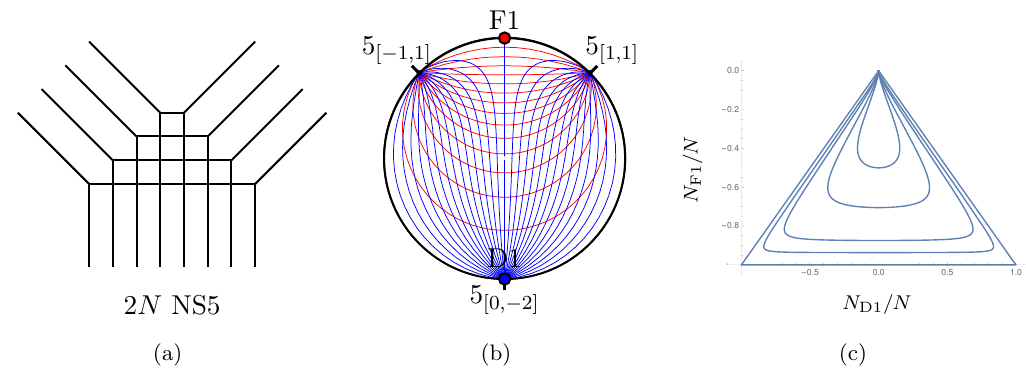
Figure 6 . Left: brane web for the gauge theory (2.38). Center: Y N supergravity solution on the disc, with the 5-brane poles and string embedding. Along the red/blue curves the D3-brane has constant F1/D1 charge. Right: ( N D1 ; N F1 ) curves, from outer to inner curve for Im( w ) 2 (cid:8) (cid:9) 10 (cid:0) 6 ; 1 ; 1 ; 1 ; 1 . The F1/D1 charges carve out the grid diagram of the web in (cid:12)gure 6(a) and 10 5 2 identify the vertical/horizontal coordinate of the face in which the D3-brane is located in the brane